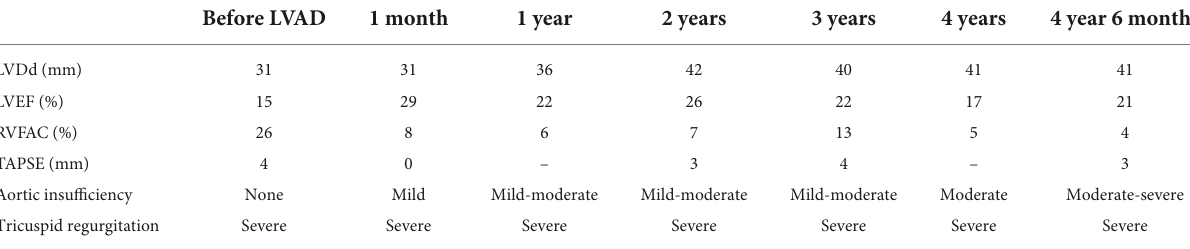
LVDd, left ventricular end-diastolic dimension; LVEF, left ventricular ejection fraction; RVFAC, right ventricular fractional area contraction; TAPSE, tricuspid annular plane systolic